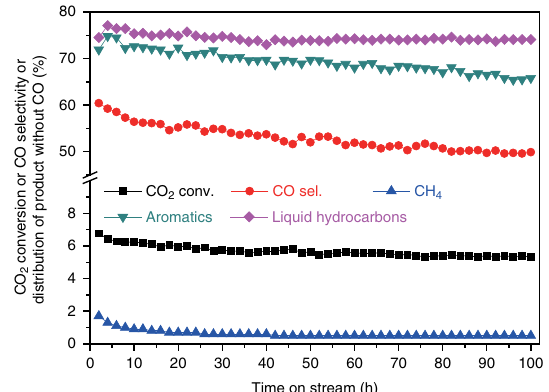
Fig. 2 The stability test for CO 2 hydrogenation over ZnAlO x &H-ZSM-5. Reaction conditions: Space velocity = 6000 ml g − 1 h − 1 , 3.0 MPa, 593 K, H 2 /CO 2 /Ar = 3/1/0.2. Note that the liquid hydrocarbons include aromatics